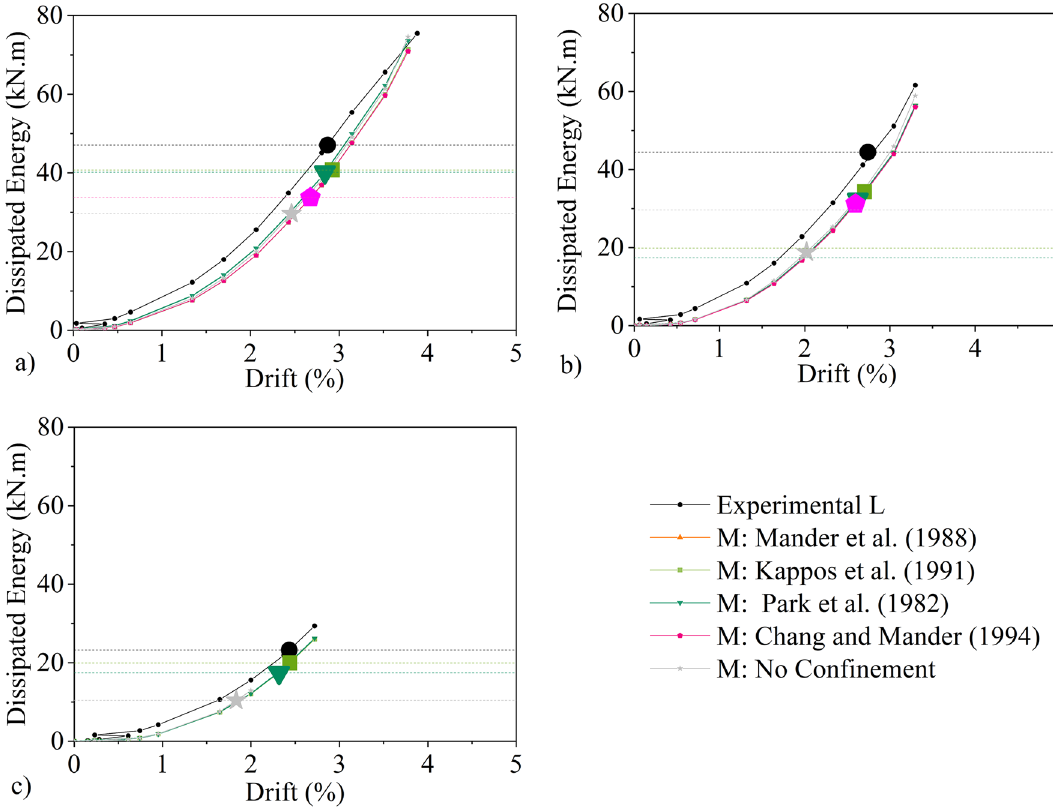
Figure 14. Dissipated energy evolution: ( a ) Experimental Results, ( b ) column C, ( c ) column M, ( d ) column L.